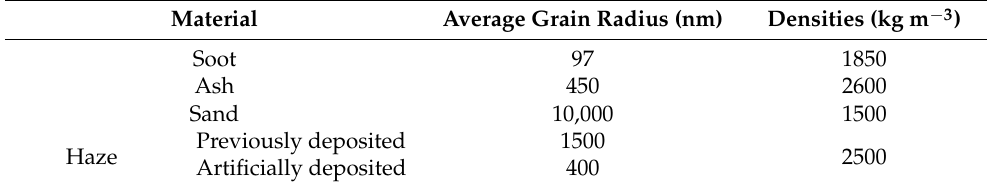
Table 2. Materials average grain radius and densities (previously deposited refers to “clean”